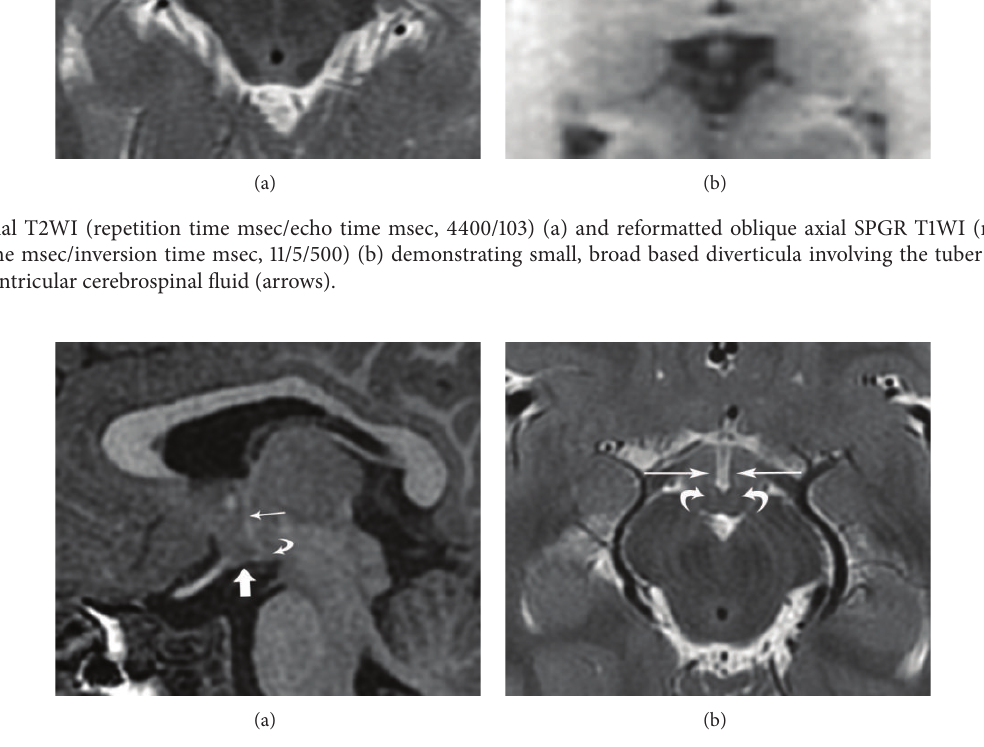
Figure 5: (a) Parasagittal SPGR T1WI (repetition time msec/echo time msec/inversion time msec, 8/3/450) from a 3-year-old male depicting normal brain anatomy. The lateral portion of the hypothalamic tuber cinereum has a straight outer contour (thick arrow), in contrast to the diverticulum shown in Figure 2. The normal mammillary body (curved arrow) and forniceal column (thin arrow) are partially visible. (b) Axial T2WI (repetition time msec/echo time msec, 3200/111) from a 3-year-old male showing normal hypothalamic anatomy. Hypothalami are visible near midline, marginating the 3rd ventricle (straight arrows). The inner margins of the hypothalami are uniformly straight apart from the rounded contour of the mammillary bodies (curved